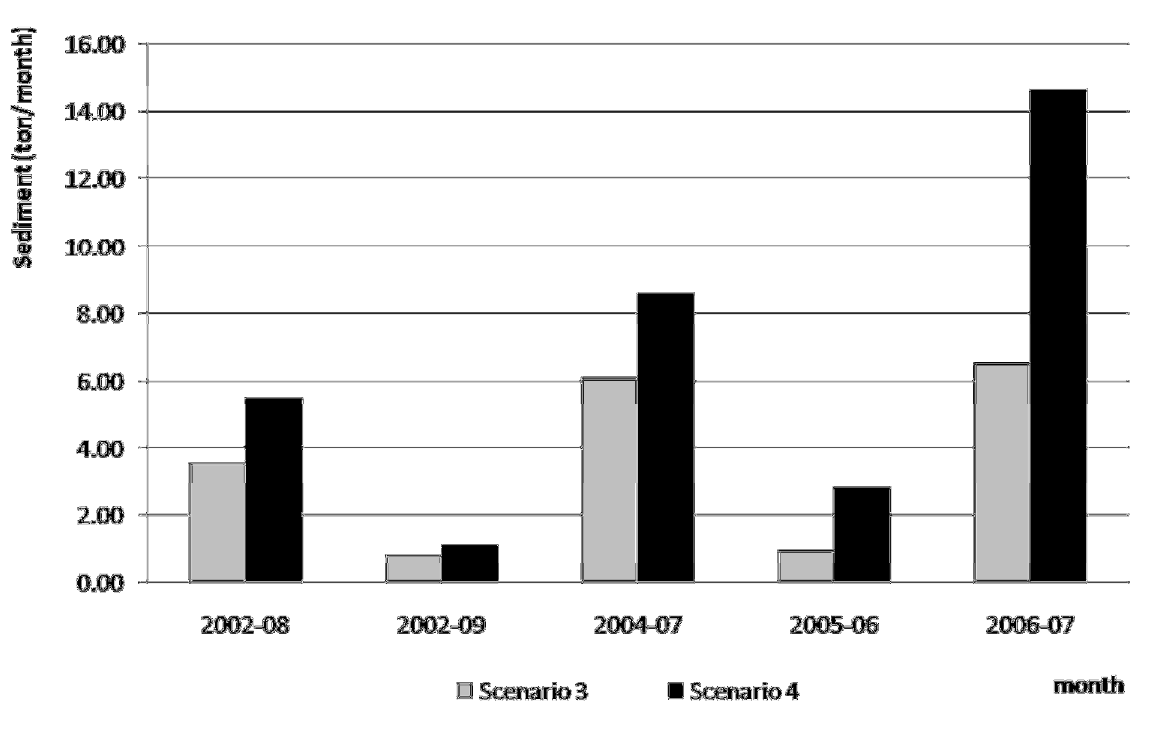
Figure 21. Simulated Monthly Sediment at Subwatershed 5–receiving subwatershed in SG 4